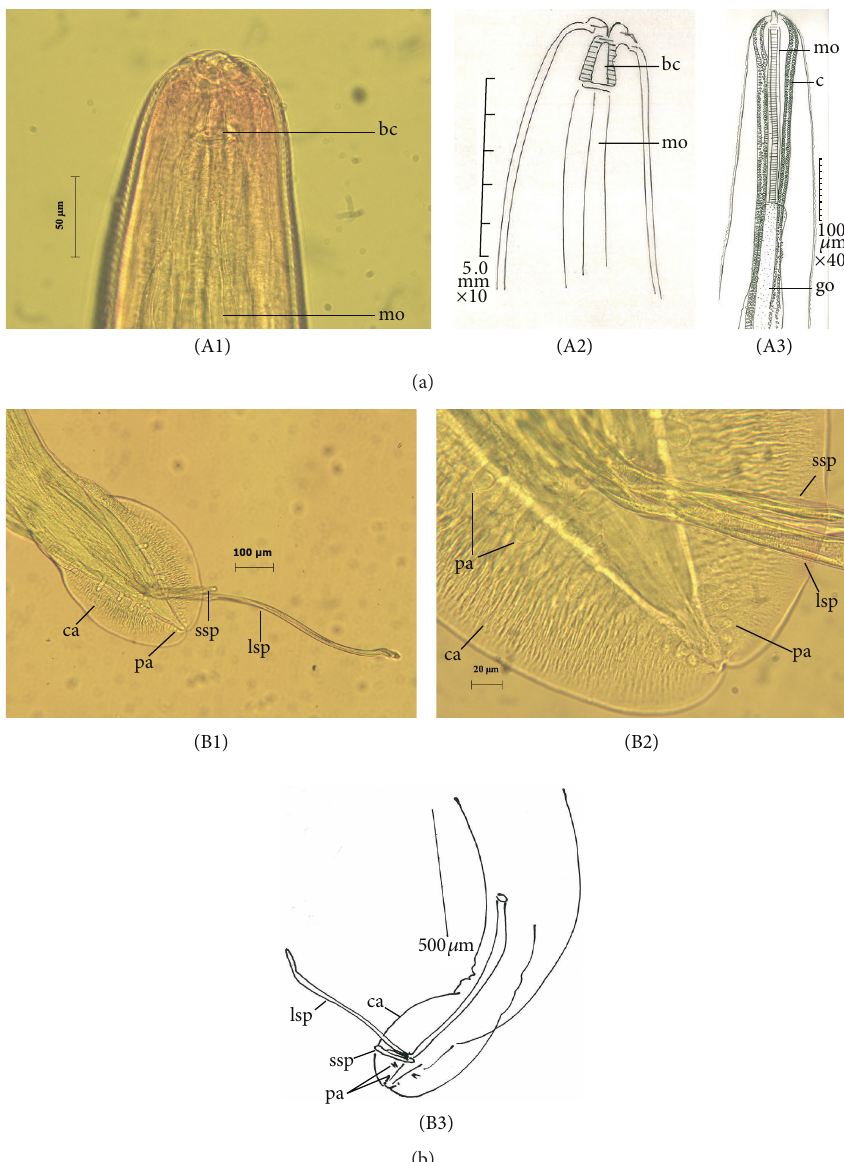
Figure 2: Male of Cheilospirura hamulosa ; light micrographs and camera lucida. (A1) Enlarged view of the anterior region, buccal cavity (bc), muscular oesophagus (mo); (A2) anterior end, lateral view, buccal cavity (bc), muscular oesophagus (mo); (A3) anterior end, sublateral view, muscular oesophagus (mo), glandular oesophagus (go), and cordon (c); (B1) and (B2) male posterior end, showing small (ssp) and large (lsp) spicules, caudal alae (ca), and caudal papillae (pa); (B3) posterior end of male, lateral view, papillae (pa), long spicule (lsp), short spicule (ssp), and caudal alae